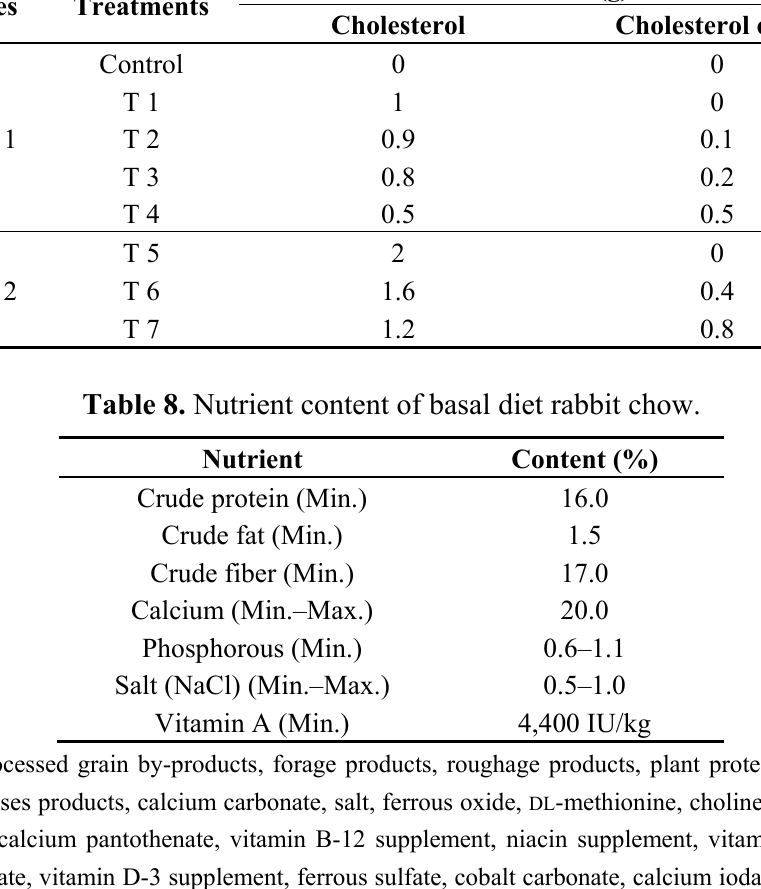
Table 7. Experimental design and amount of cholesterol and cholesterol oxides. Studies